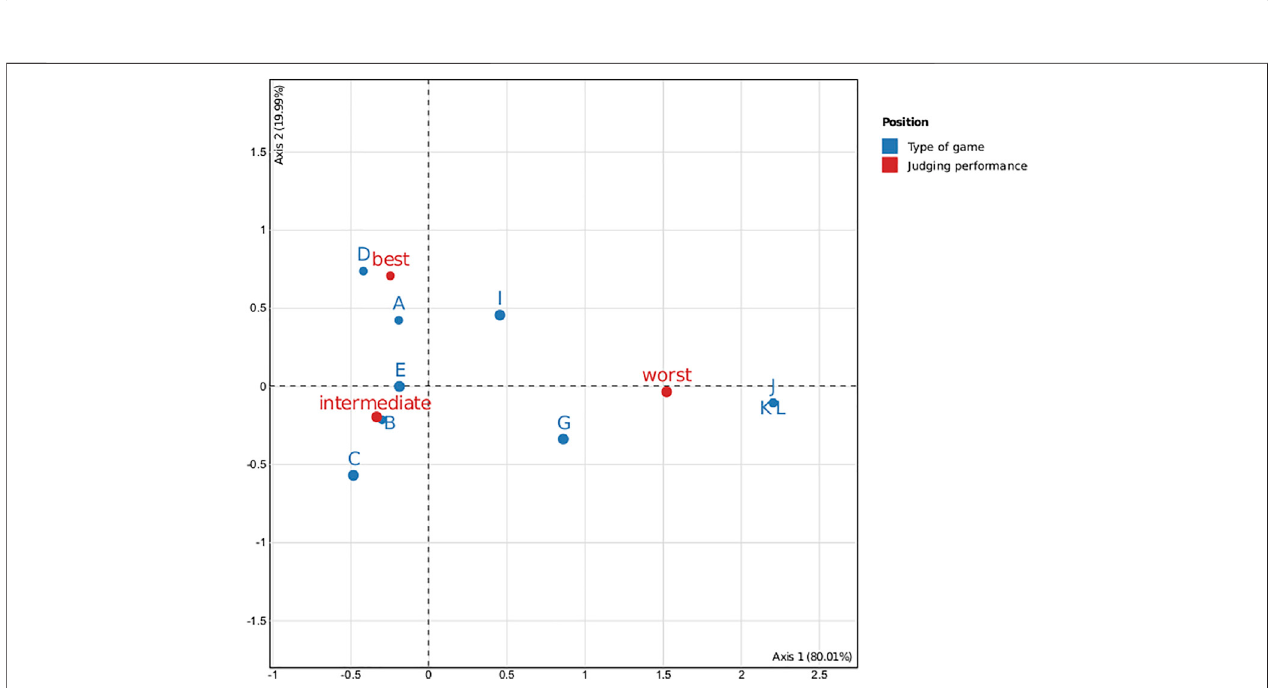
FIGURE 7 | Correspondence analysis factor